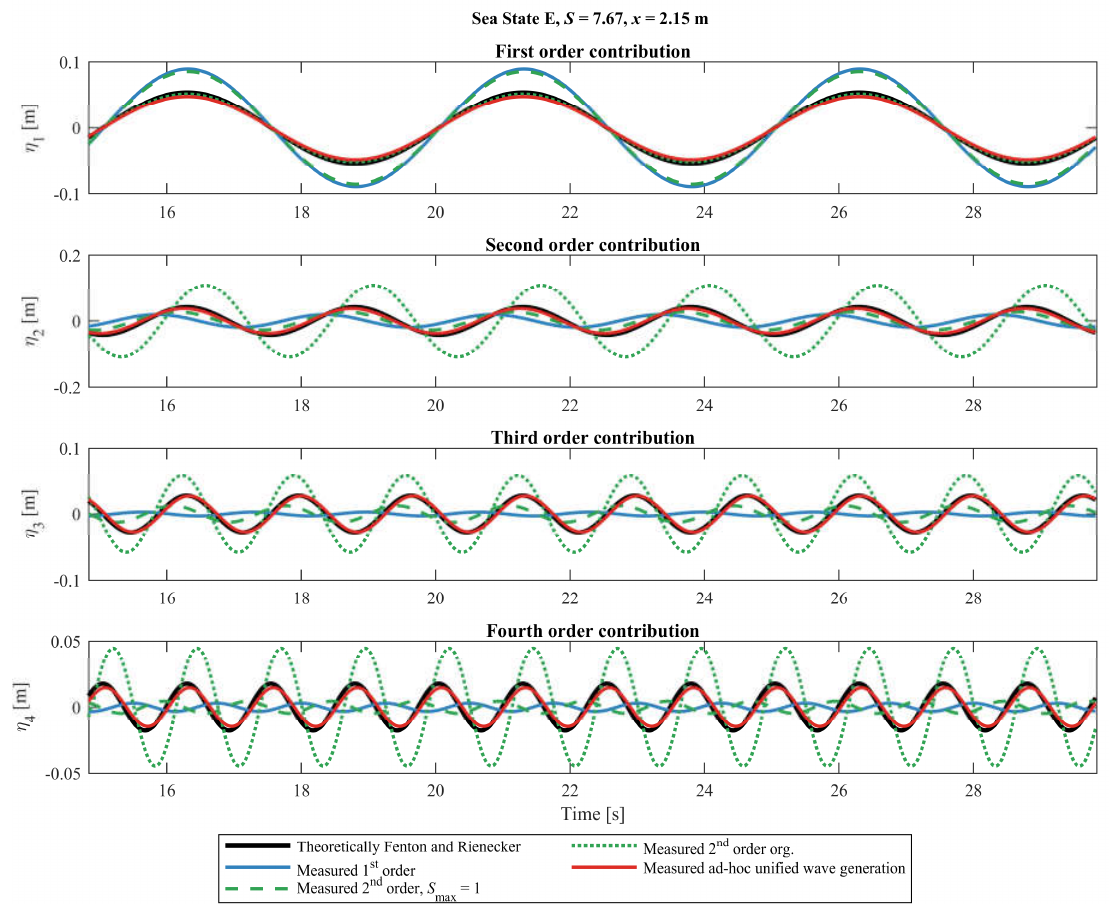
Figure 10. Contribution of the first four harmonics to the surface elevation for Sea State E at x = 2.15 m. First-order, second-order, modified second-order and the ad-hoc unified wavemaker method are compared with the theoretical harmonics in stream function waves.